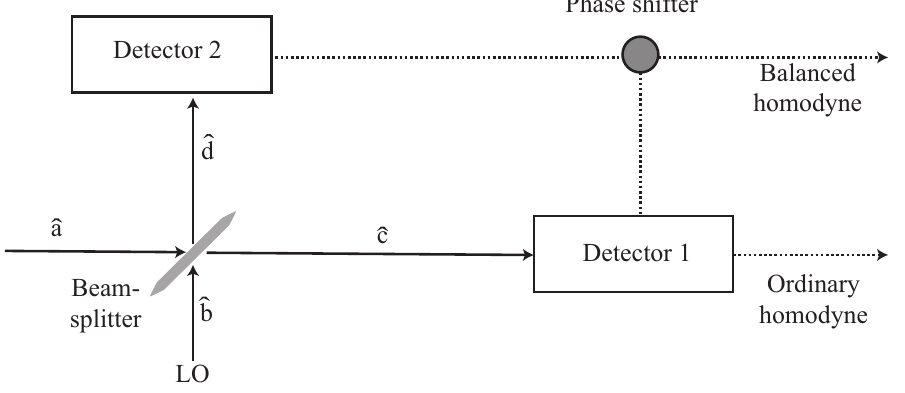
Figure A1. Setup for homodyne (and heterodyne)